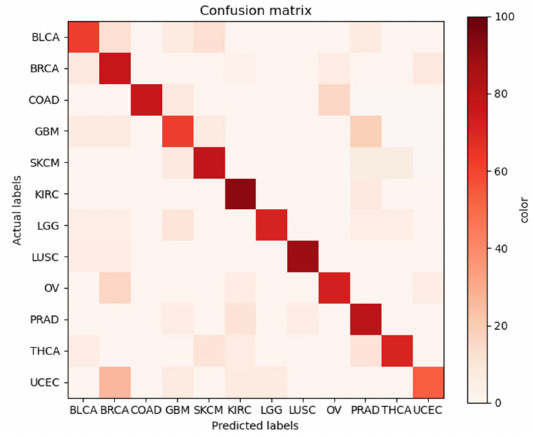
Figure 3. Confusion matrix of 12